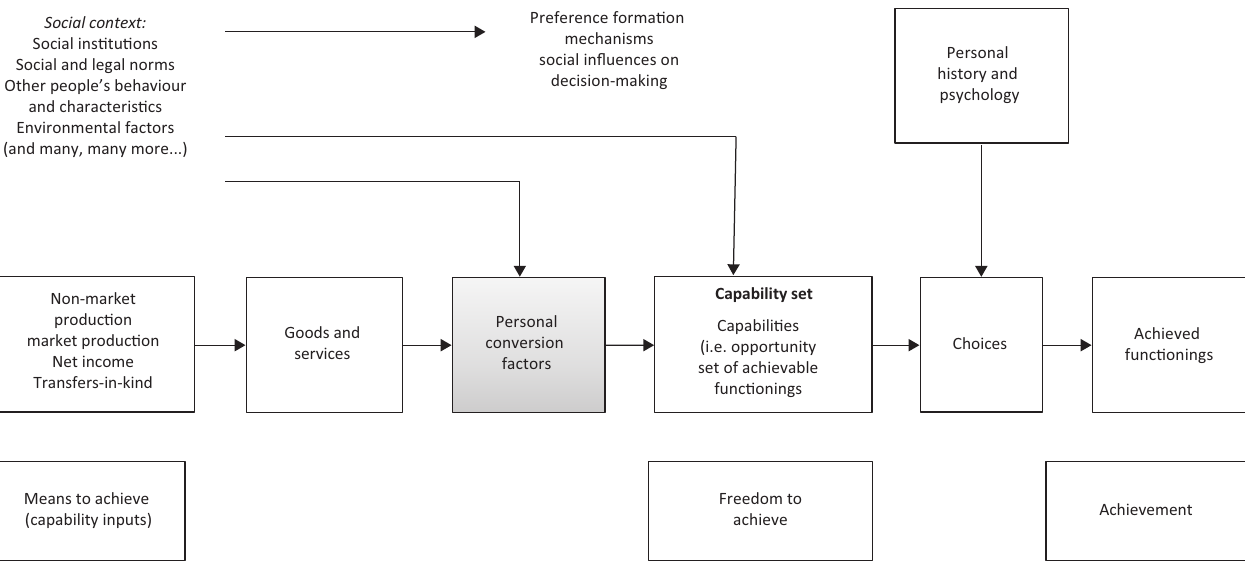
FIGURE 2: A person’s capability set and his or her social and personal context.